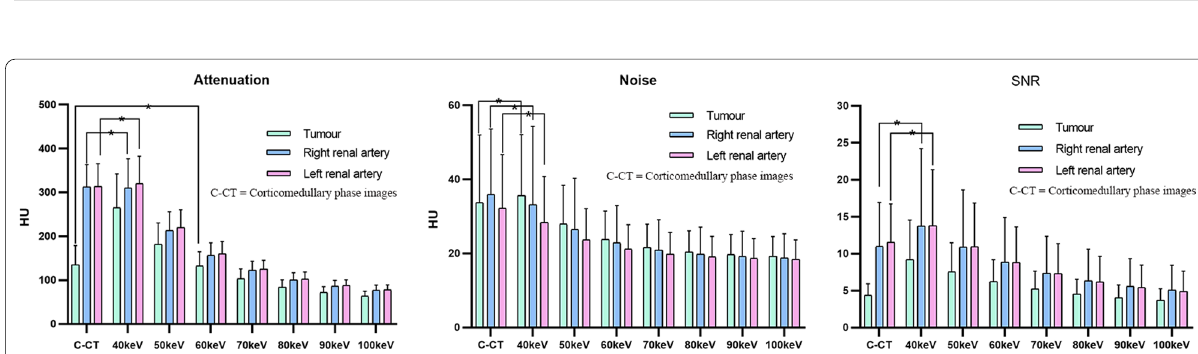
unreadable to 5 excellent = =